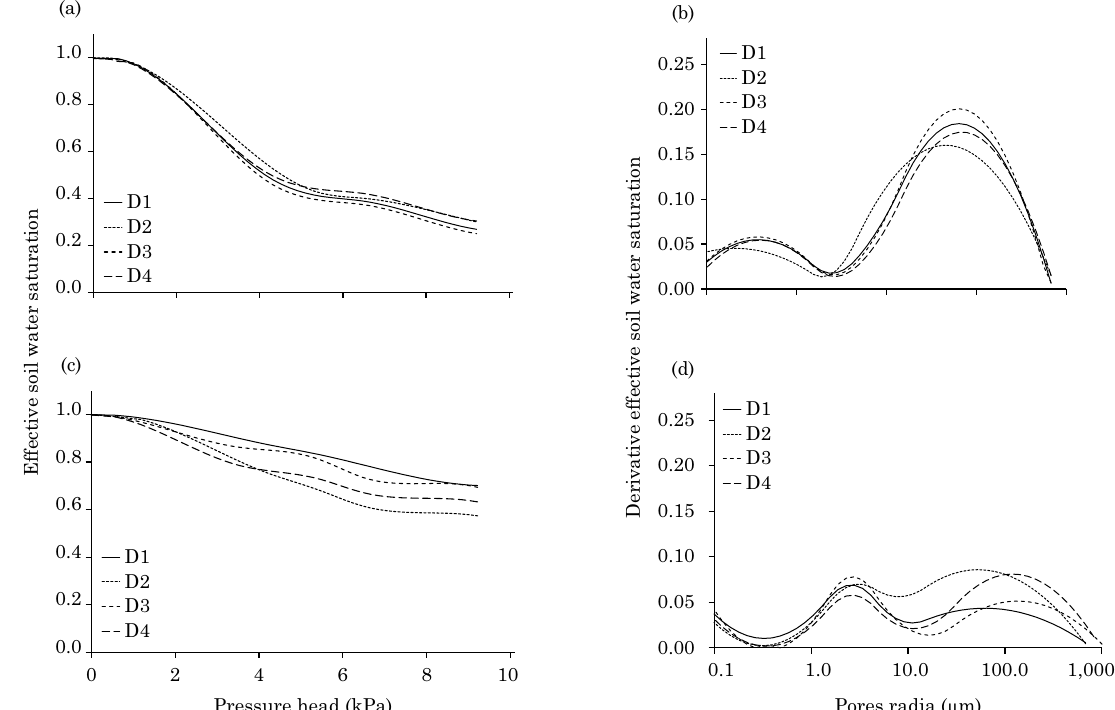
Figure 5. Effective soil water saturation (S e ) curves versus water pressure head (h) and contrasting pore size distributions (PSDs) under the continuous arable cropping sytem (a,b) and natural bush fallow system (c,d) for depths D1 (0-5 cm), D2 (5-10 cm), D3 (10-15 cm), and D4 (15-20 cm).